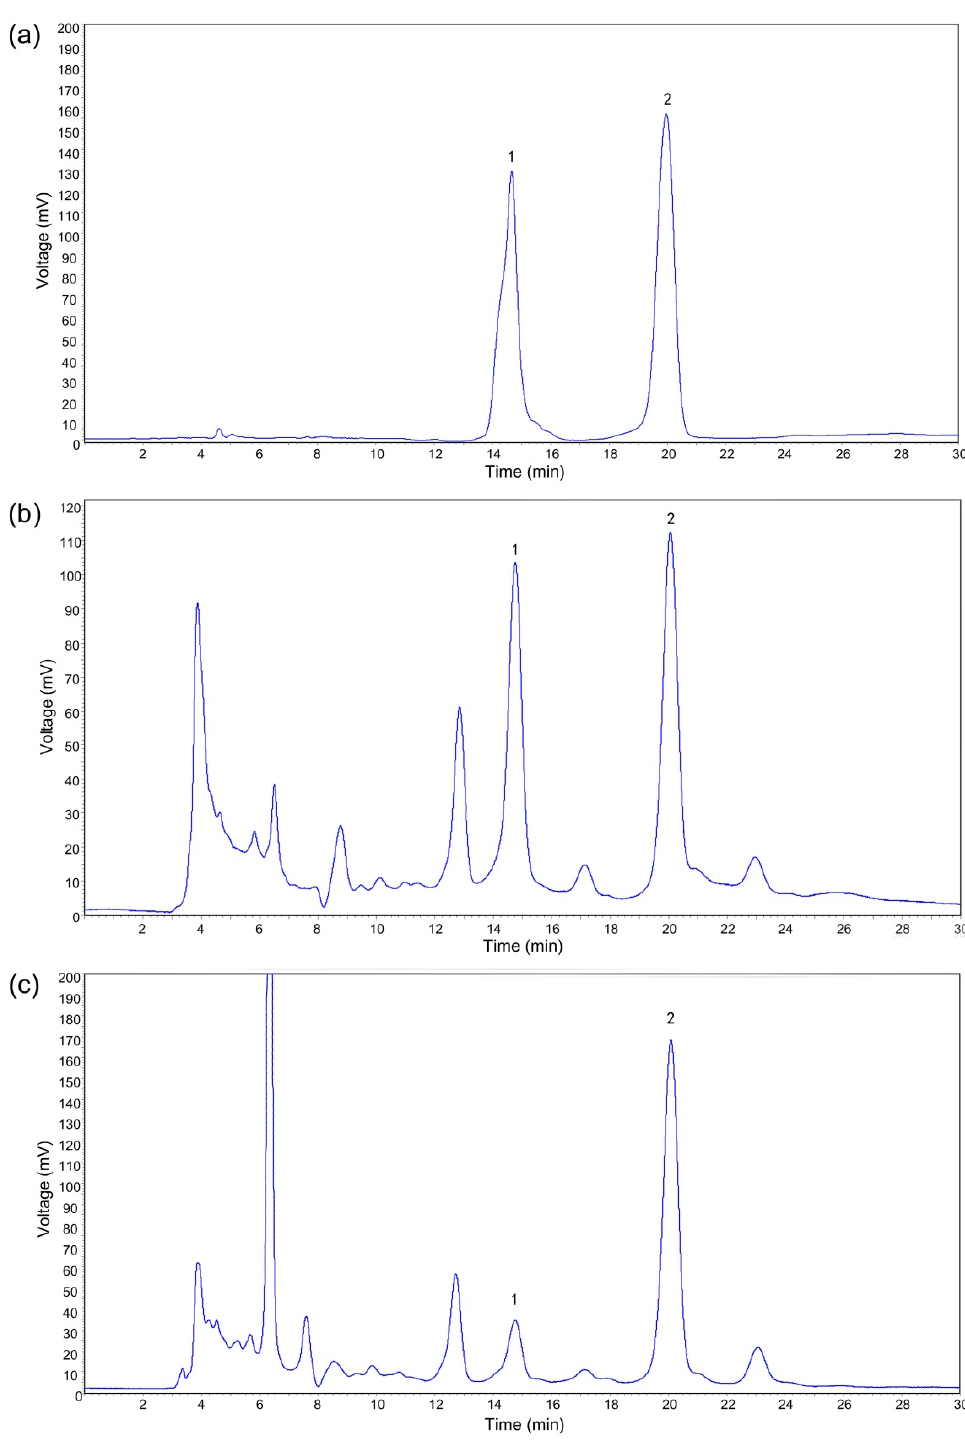
Figure 6. HPLC–UV chromatograms of cucurbitacin B 2- O - β - D -glucoside (CuBg) and cucurbitacin B (CuB). ( a ) Standard CuBg and CuB dissolved in methanol. ( b ) C. melo pedicel extracts without bio- transformation. ( c ) C. melo pedicel extracts after biotransformation by the recombinant β -glucosidase. 1, CuBg; 2, CuB.